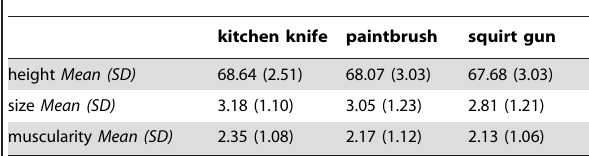
Table 4. Estimated Height, Size, and Muscularity (Study